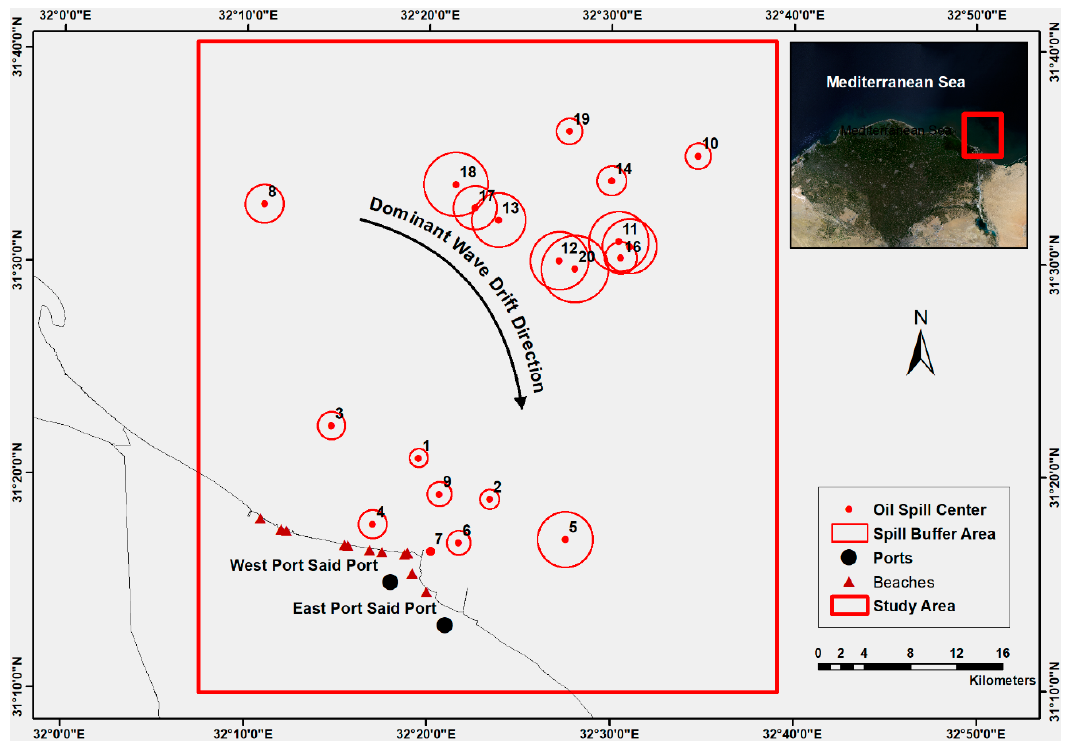
Figure 9. Hazards map of the oil spills near the Suez Canal entrance.